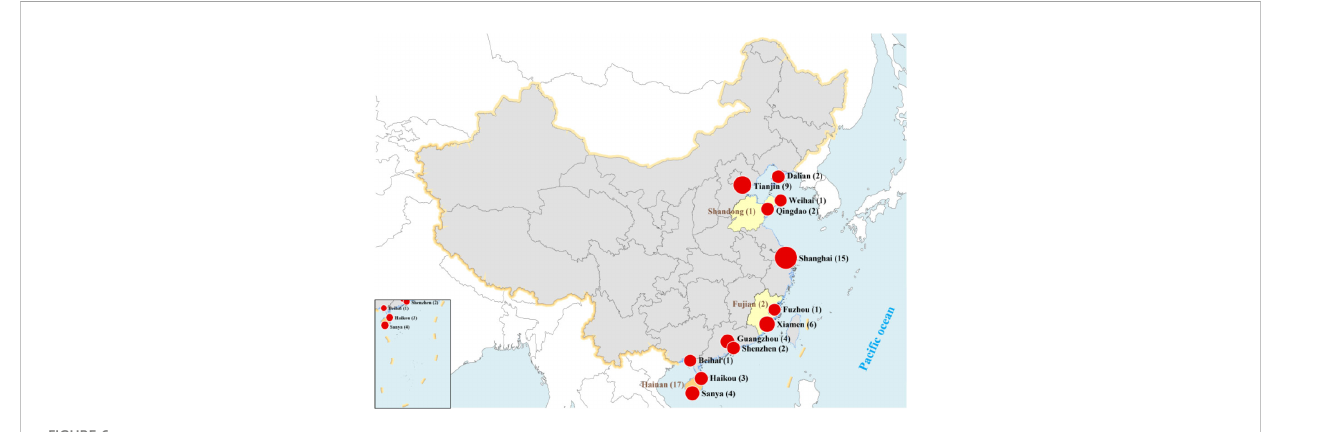
FIGURE 6 Local cruise policies issued by cities and provinces.